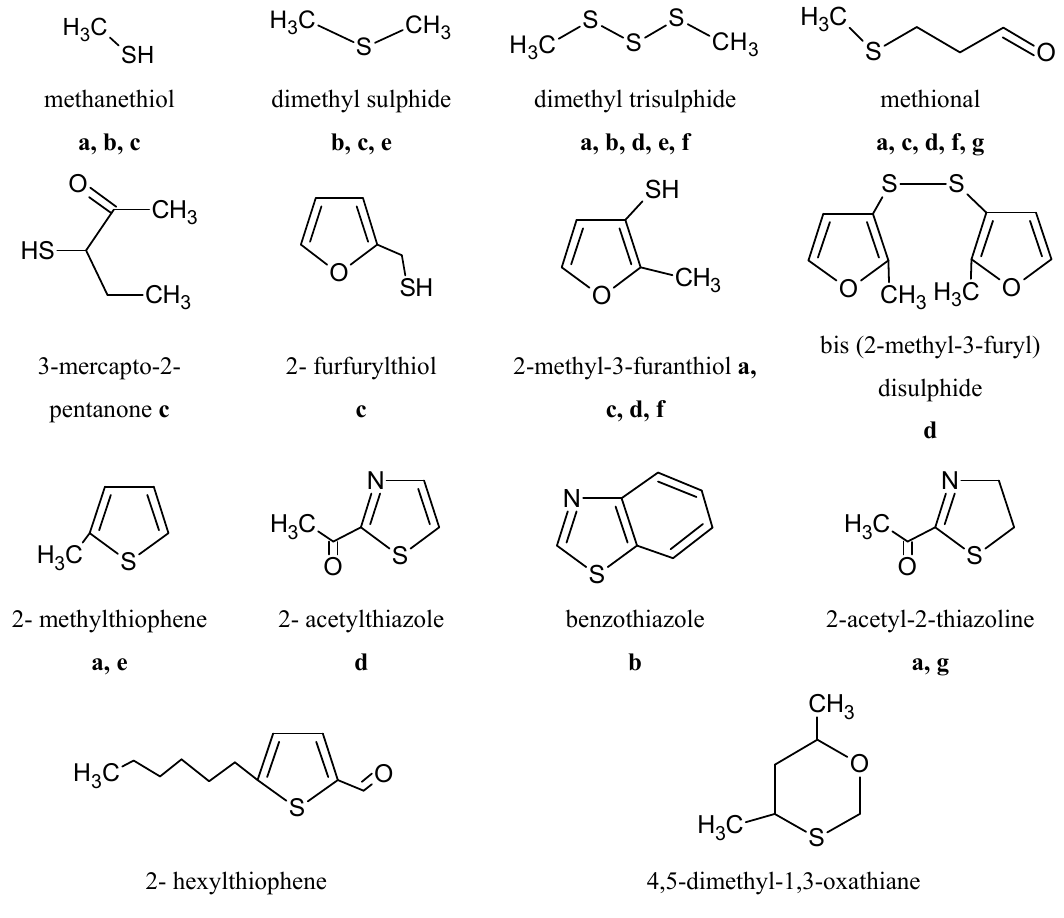
Figure 1. Sulphur compounds detected by GC-O in the aroma of beef and